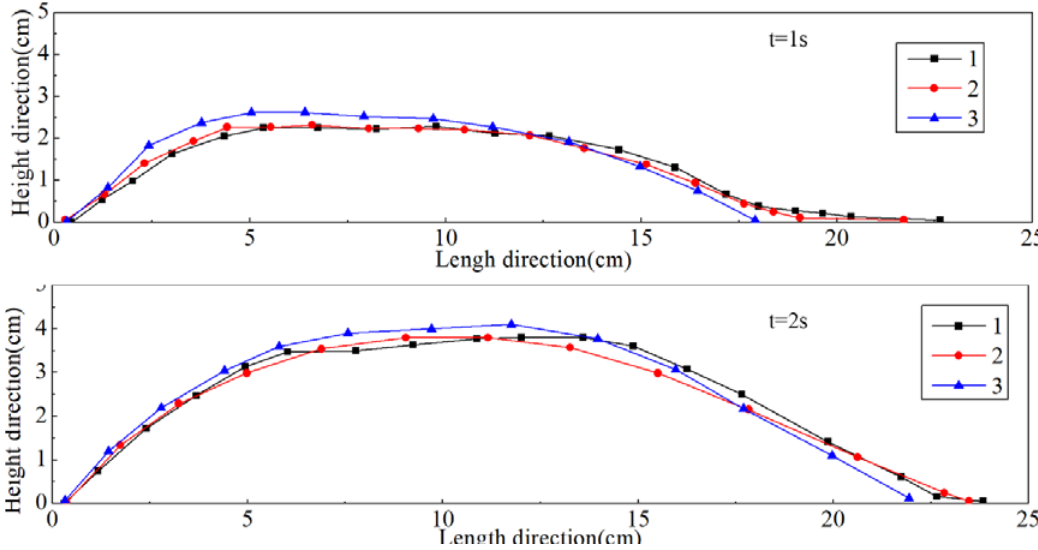
Figure 15. The distribution of single-sized proppants in smooth fracture.